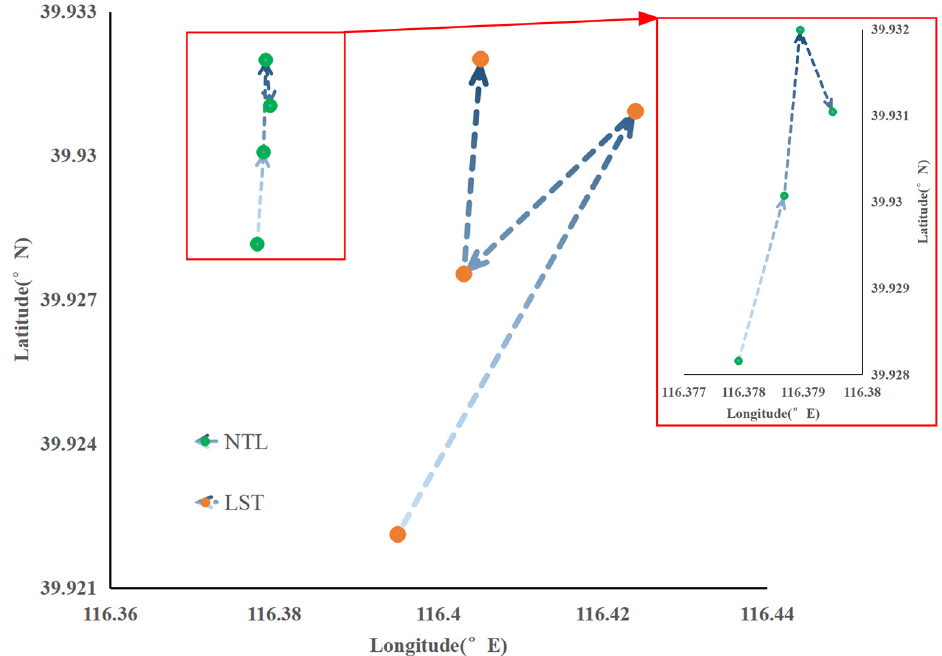
Figure 5. Trajectory of the LST and NTL weighted center within the sixth ring road of Beijing from 2004 to 2019.